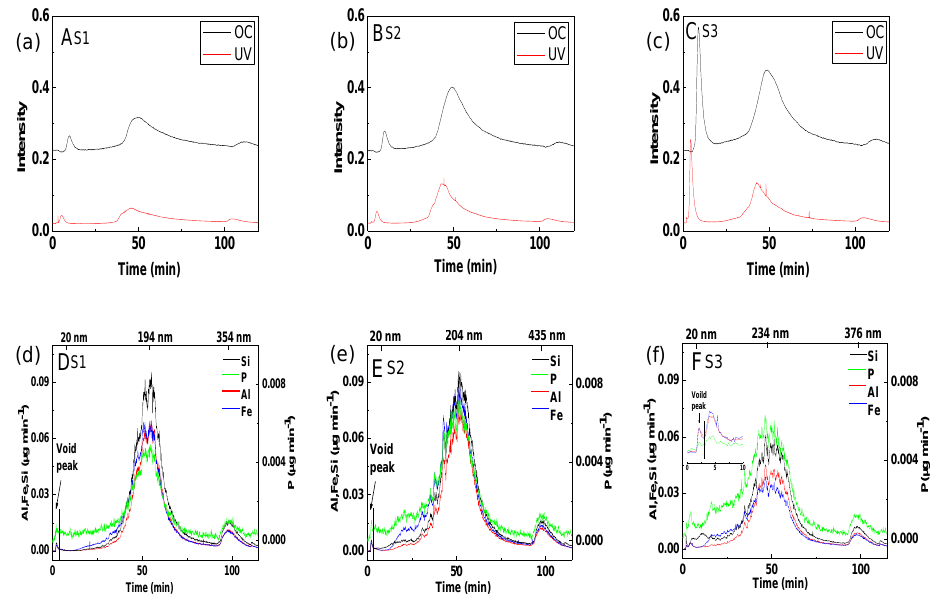
Figure 2. Asymmetric flow field-flow fractionation (AF4) fractograms of water-dispersible fine colloids (WDFCs) of S1, S2, and S3. The fractograms show the organic carbon (OC) and ultraviolet (UV) signal intensities (a, b, c) and the Fe, Al, P, and Si mass flow (d, e, f) monitored by inductively coupled plasma mass spectrometer (ICP-MS) of S1 (Cambisol), S2 (Stagnic Cambisol), and S3 (Stagnosol). The sizes of peaks were according to the AF4 result of sulfate latex standard particles and dynamic light scattering results. The OC and UV peaks occurred with elements (ICP-MS) peaks at the same time and the slight delay among these peaks is due to the different length of tubes to different detectors, which cause slightly different internal volume and retention